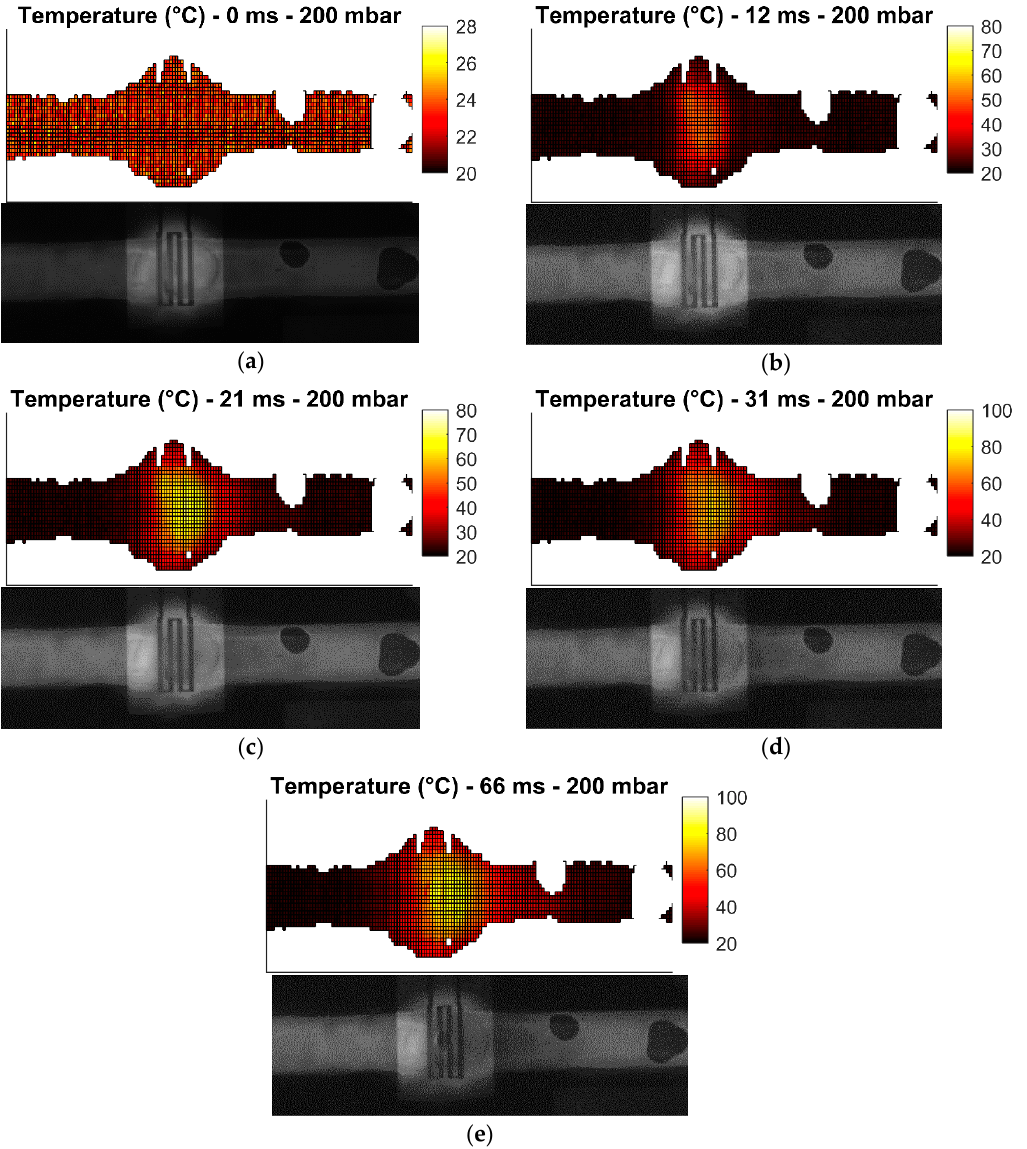
Figure 11. Measured temperature profile (top) of the fluorescent mixture in the channel with the corresponding image (bottom) from the camera for the pressure difference of 200 mbar after: ( a ) prior to heating; ( b ) 12 ms heating started; ( c ) 21 ms heating started; ( d ) 31 ms heating started; ( e ) 66 ms heating started.